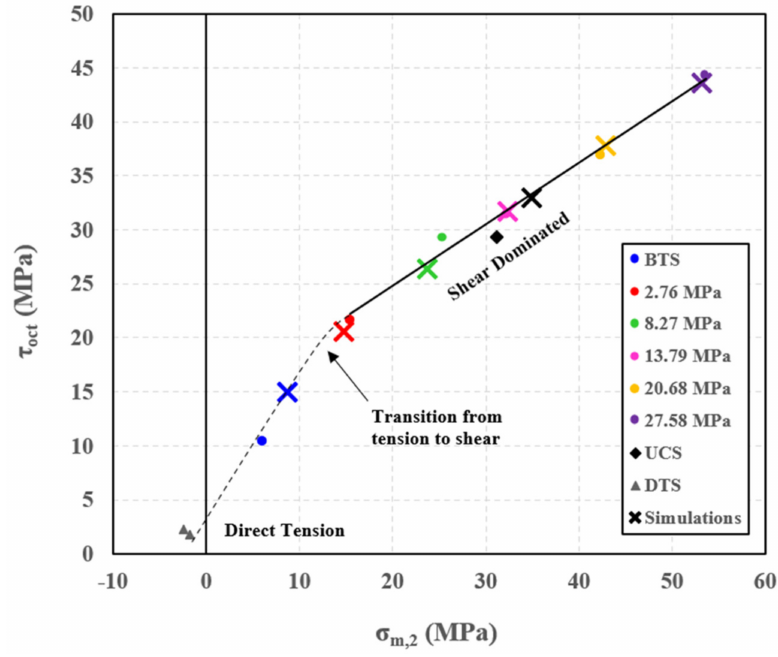
Figure 11. Failure curve represented in σ m,2 vs. τ oct stress space plotted with the average failure stresses at each confining pressure. Each of the six simulations are represented with X